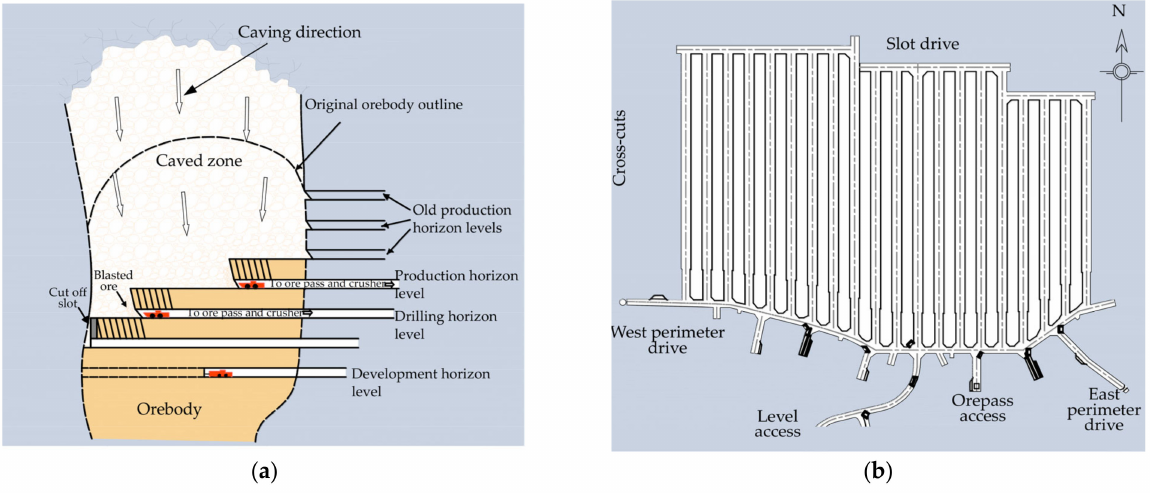
Figure 4. ( a ) Diagrammatic long section of sublevel caving; ( b ) diagrammatic plan of sublevel caving [38]. Table 1. Extent of the mining activity at different